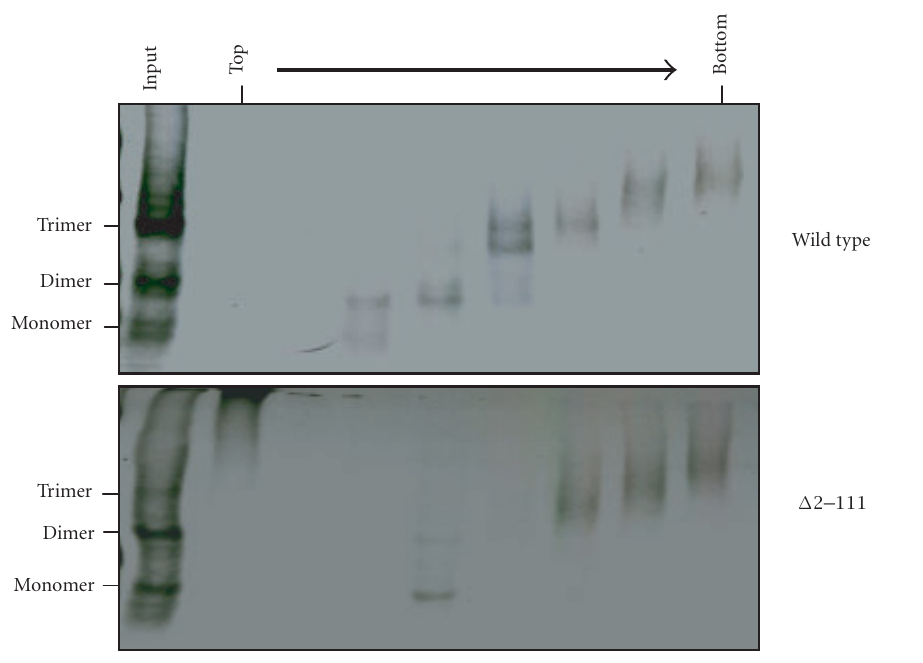
Figure 2: COS- 1 cells transfected with wild type or ∆ 2 – 111 ORF 2 expression plasmids were lysed 48 hours post-transfection, the lysates cross-linked with glutaraldehyde and separated on a sucrose gradient as described in materials and methods. The gradient fractions were immunoprecipitated with anti-pORF 2 antibodies and analyzed on nonreducing 3 . 5 % polyacrylamide